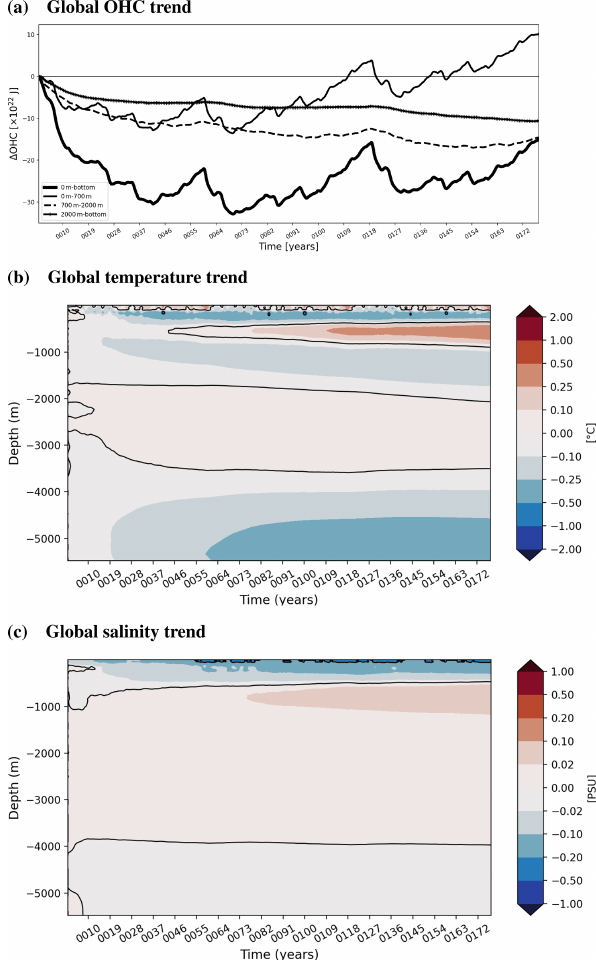
Figure 2. Global trends for the E3SM-Arctic-OSI simulation of (a) ocean heat content (OHC) anomalies integrated over the full depth column (thick solid line) and over the following depth ranges: 0–700m (thin solid line), 700–2000m (dashed line), and 2000m– bottom (plus line); (b) temperature and (c) salinity anomalies as a function of depth. Anomalies are computed with respect to the first- year annual mean and are 1-year running